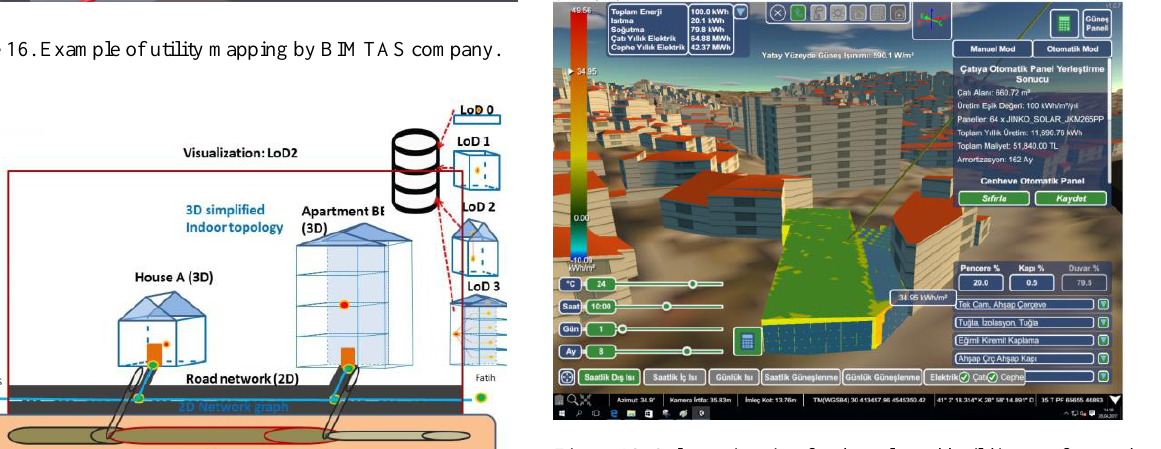
Figure 18. Solar estimation for the selected building rooftop and façade (potential solar